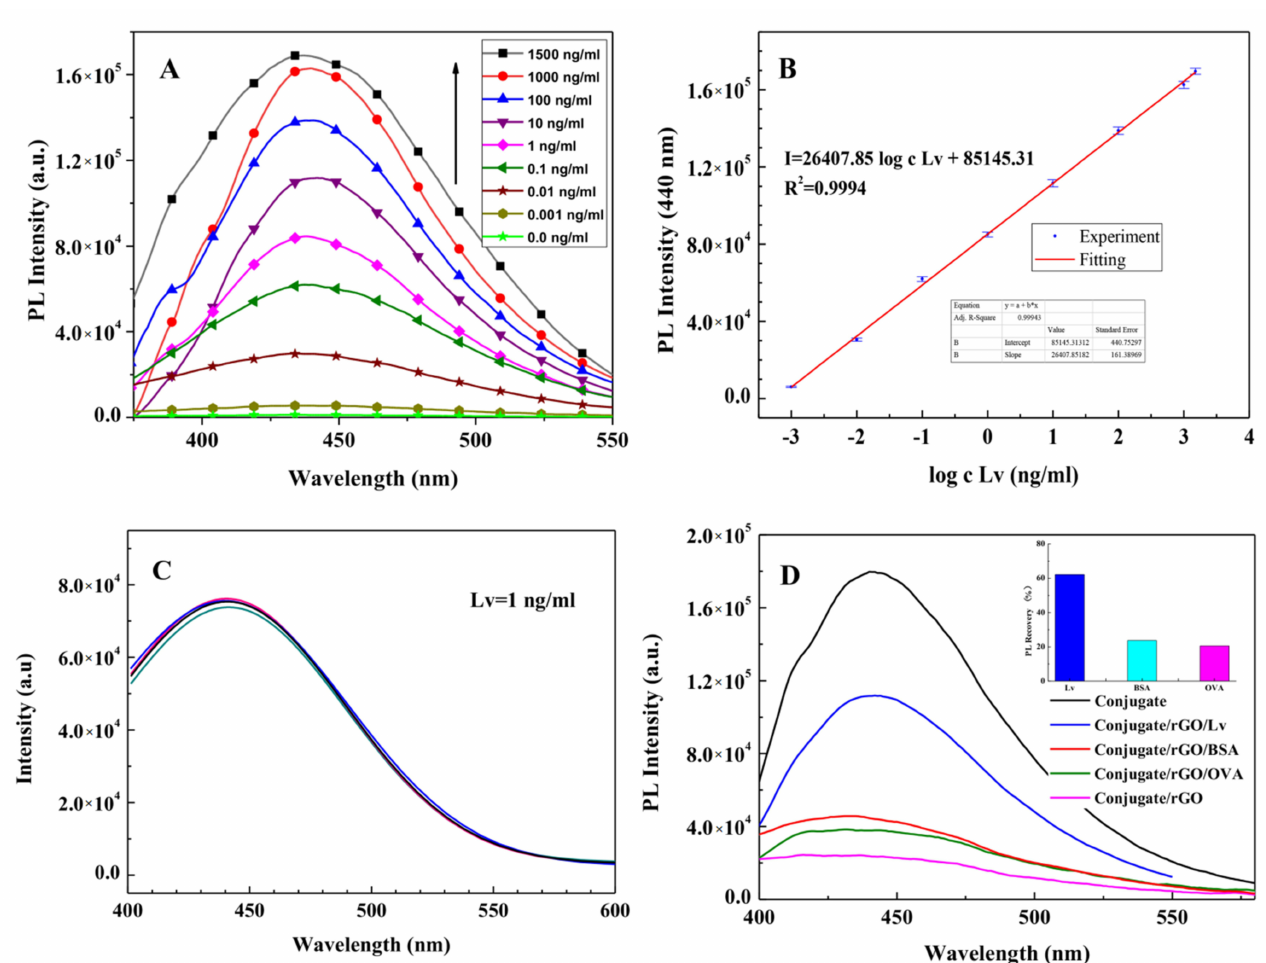
Figure 8. ( A ) PL “ON” after addition of different concentrations of Lv (0, 0.001, 0.01, 0.1, 1.0, 10, 100, 1000, and 1500 ng/mL) into Anti-Lv-mAb/afGQDs/rGO solutions; ( B ) the linear relationship between the PL regaining intensity with the logarithm concentrations of Lv from 1 pg/mL to 1500 ng/mL; ( C ) reproducibility, and ( D ) immunosensing behavior against specific (Lv) and non- specific antigen (BSA and OVA). In ( C ), addition of same amount of Lv (1 ng/mL) into 5 parallel samples of Anti-Lv-mAb/afGQDs/rGO solutions; and in ( D ), the concentration of Lv is 10 ng/mL, and OVA and BSA are 1.5 µ